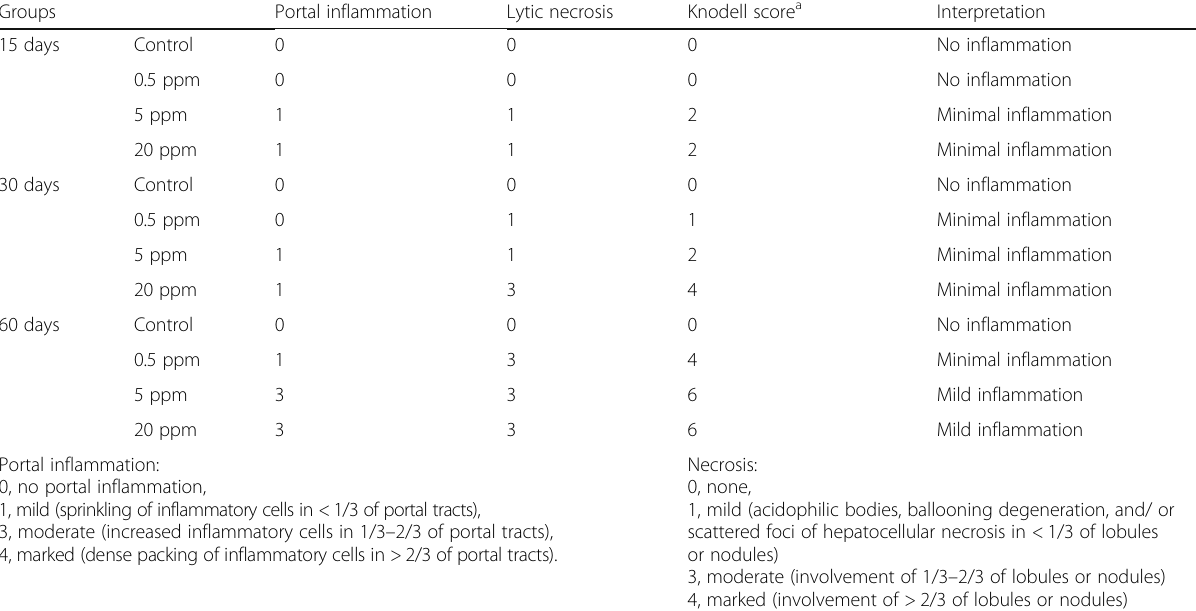
Table 2 Histopathological changes of hepatic cells in rats exposure to different concentrations of fluoride Groups Portal inflammation